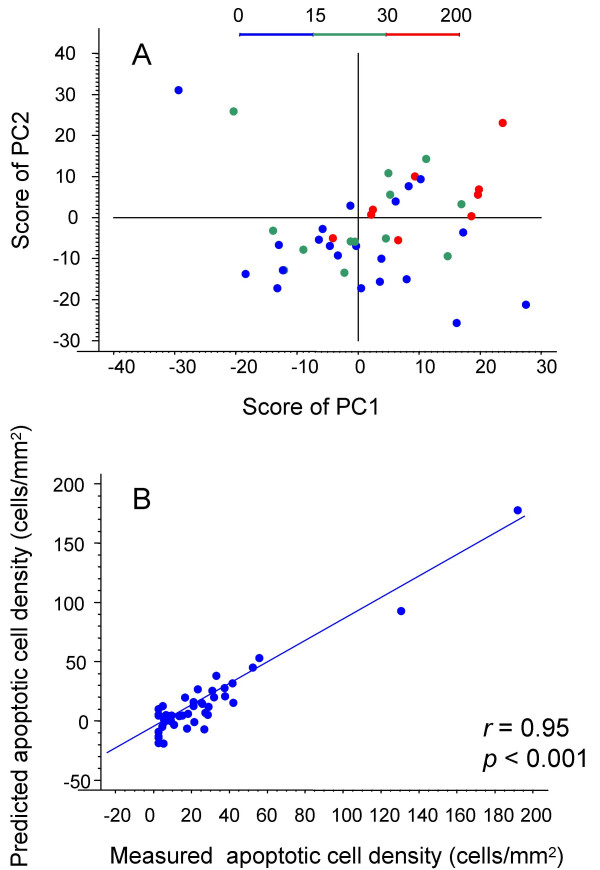
Score plot of first principal component (PC1) versus second principal component (PC2) from partial least square (PLS) regression calibration of apoptotic cell density to single-pulse spectral data (A), and the predicted versus measured apoptotic cell density (B). Each point represents the data of a single biopsy. In (A) the color code for apoptotic cell densities (cells/mm2) is shown. The Pearson correlation coefficient and p-value are marked in (B). Total residual y-variance and root mean square error of prediction were minimised by retaining 11 PCs in the model. These 11 PCs accounted for 98% of the total x-variation, and 92% of the total y-variation. An informative loading profile could not be generated due to the high number of principal components that were retained in the model.